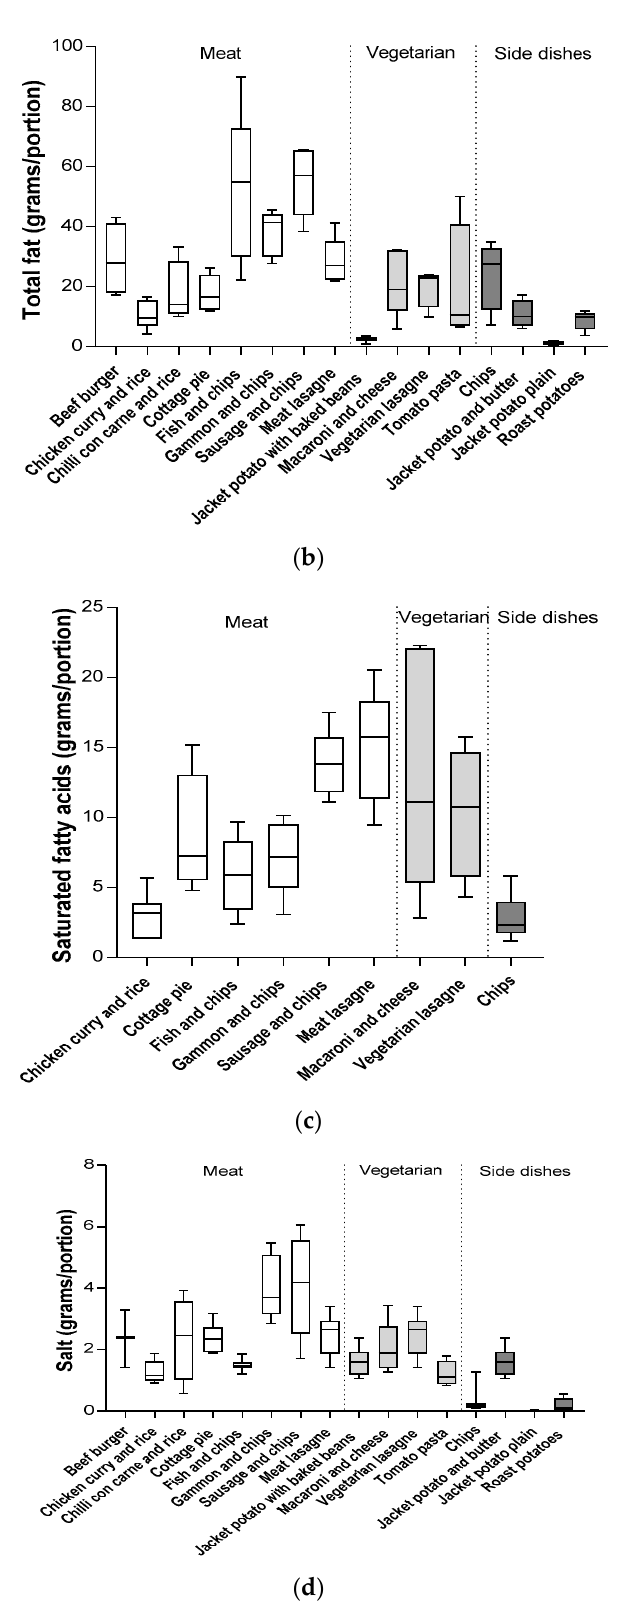
Figure 2. Variation in ( a ) energy, ( b ) total fat, ( c ) SFAs, and ( d ) salt for meat and vegetarian meals groups and for side dishes. 8